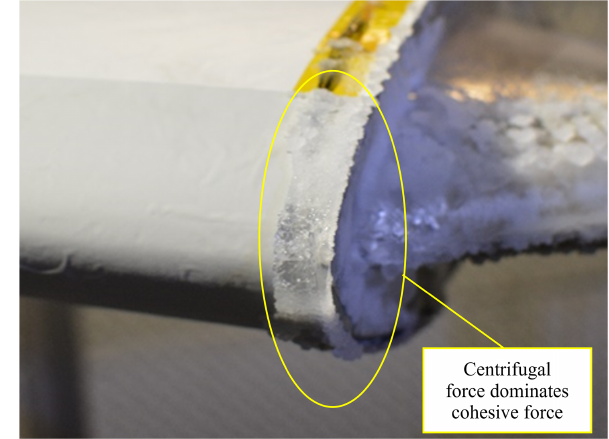
Figure 19. Successful shedding event overcoming ice cohesive forces.